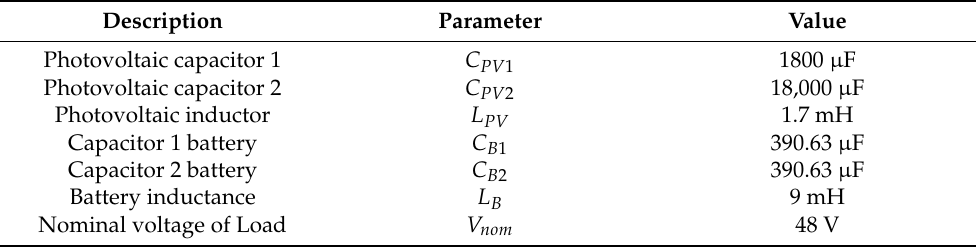
Table 4. Characteristics of the converters.